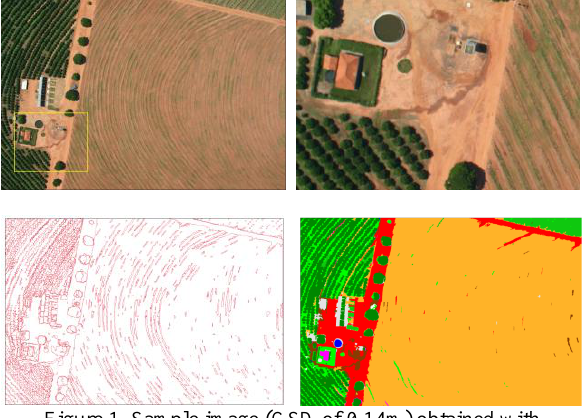
Figure 1. Sample image (GSD of 0,14m) obtained with AGplane and digital